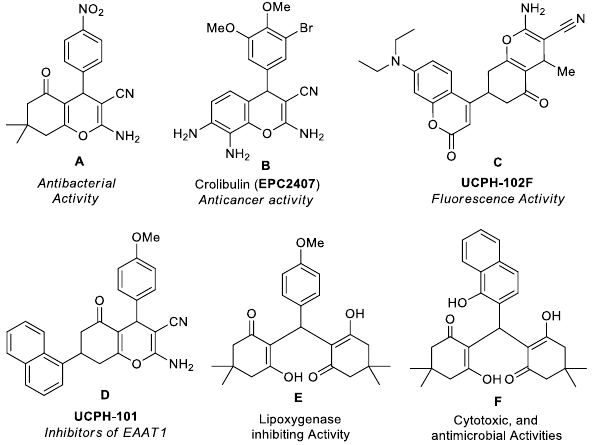
Figure 1. Examples of 2-amino-4 H -chromene ( A–D ) and tetraketones ( E–F ) with potential therapeutic and optoelectronic